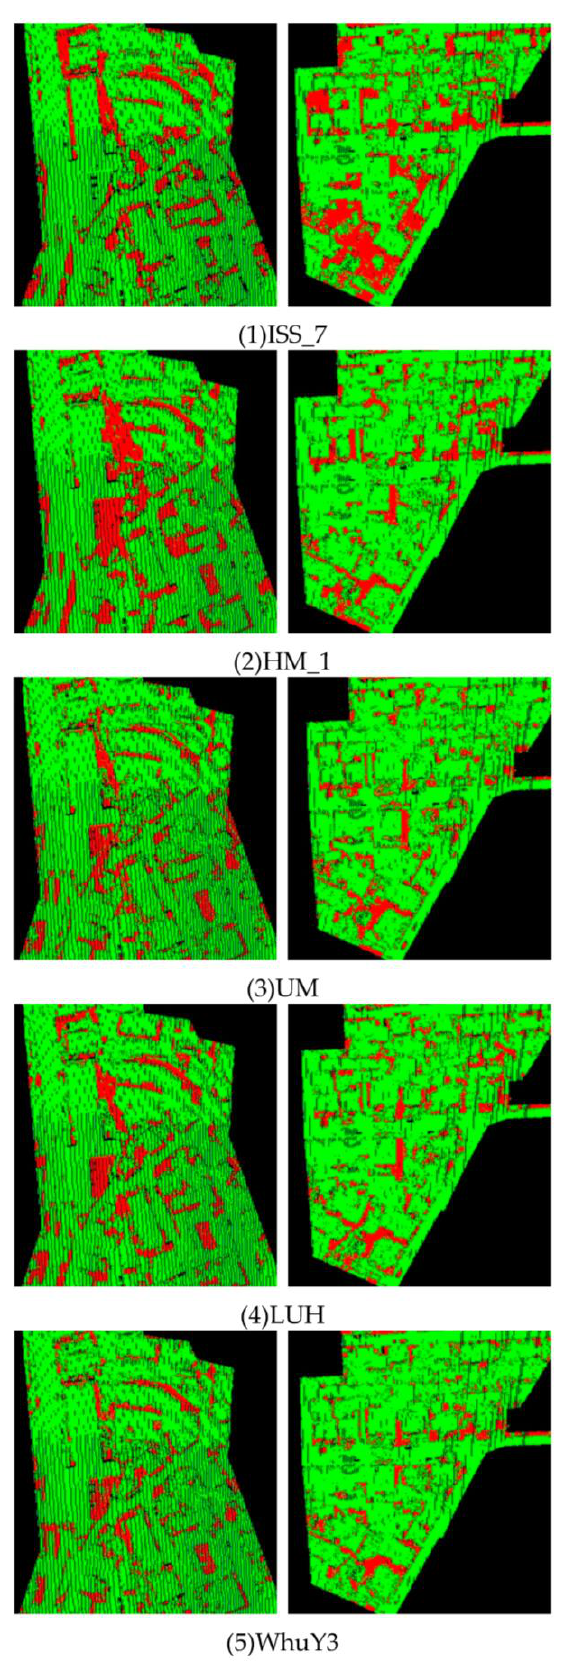
Figure 6. Visual performance among related methods. Green represents the true classification results, and red represents the false classification results.